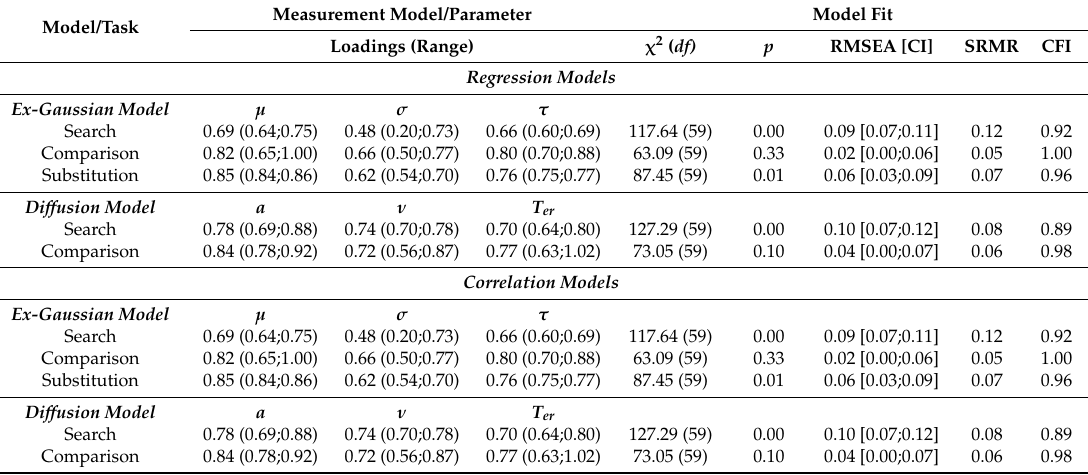
Table A3. Measurement models and model fits of RT parameter